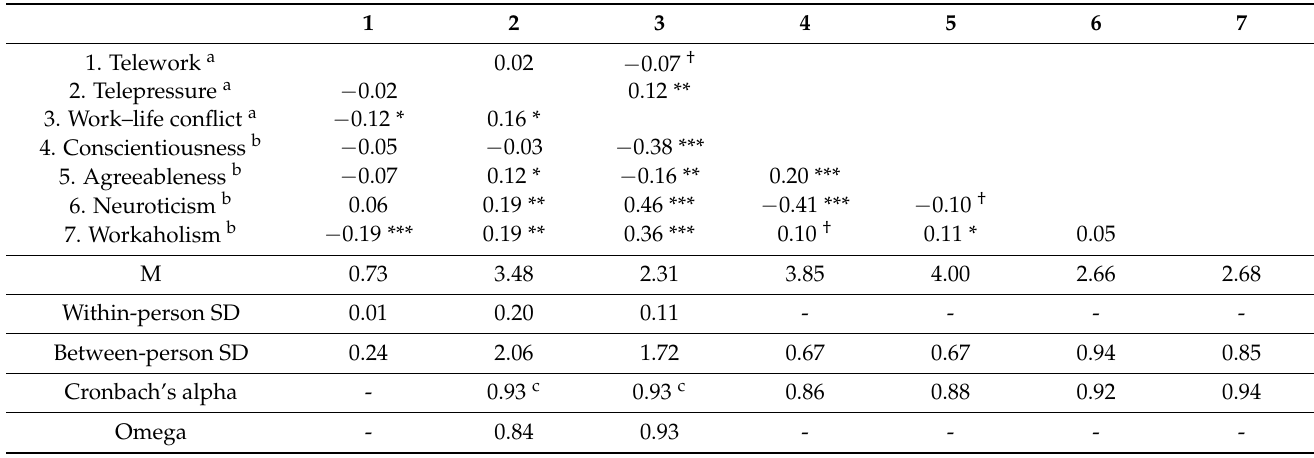
Table 1. Means, standard errors, reliability estimates, and correlations between study